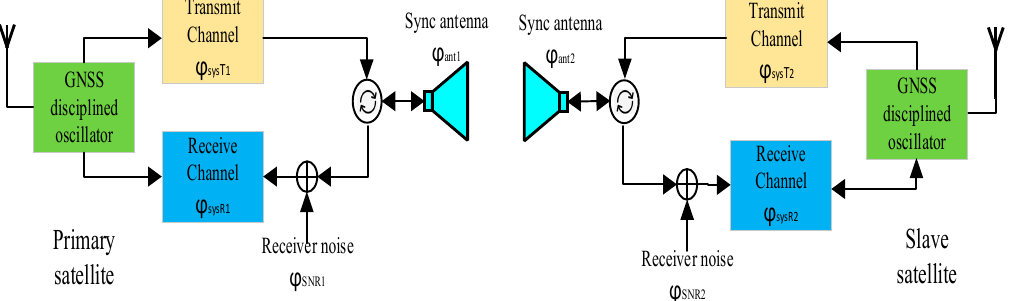
Figure 4. The hardware structure of the phase synchronization link.